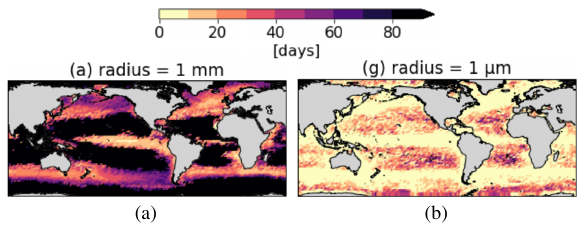
Figure 9. Final iteration of the visualisation with (i) shortened last-third of the colour scale and (ii) dark base tone to adhere to the invariance principle, reprint from (Lobelle et al., 2021),